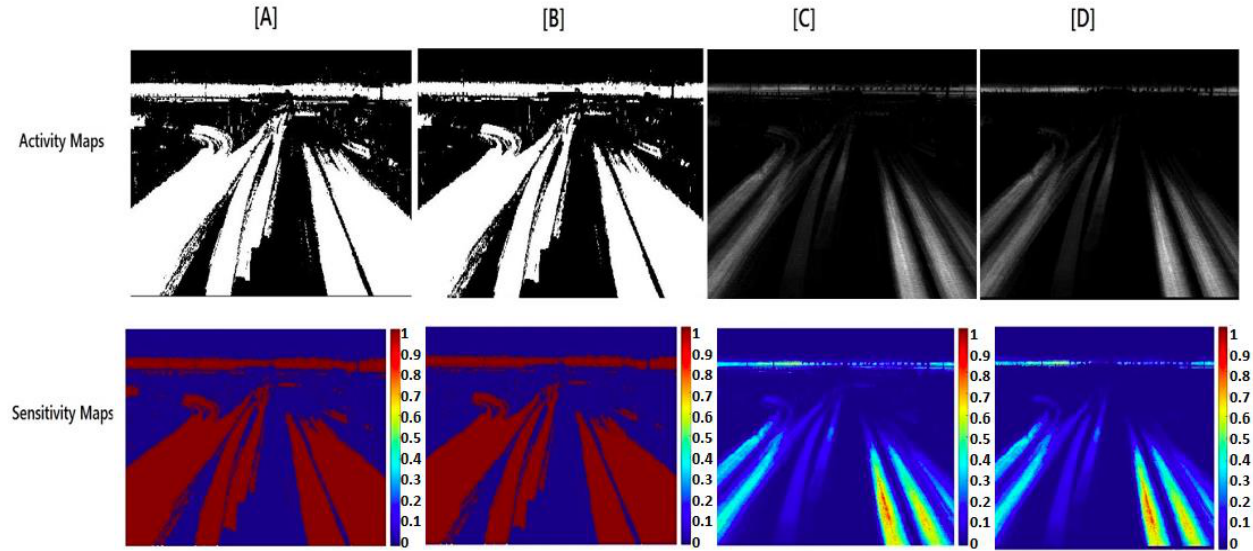
Figure 8. Simulation results from video dataset 3 by the proposed framework (( a ) extracted frames in grayscale, ( b ) foreground by adaptive background subtraction post-binarization and ( c ) optical flow).